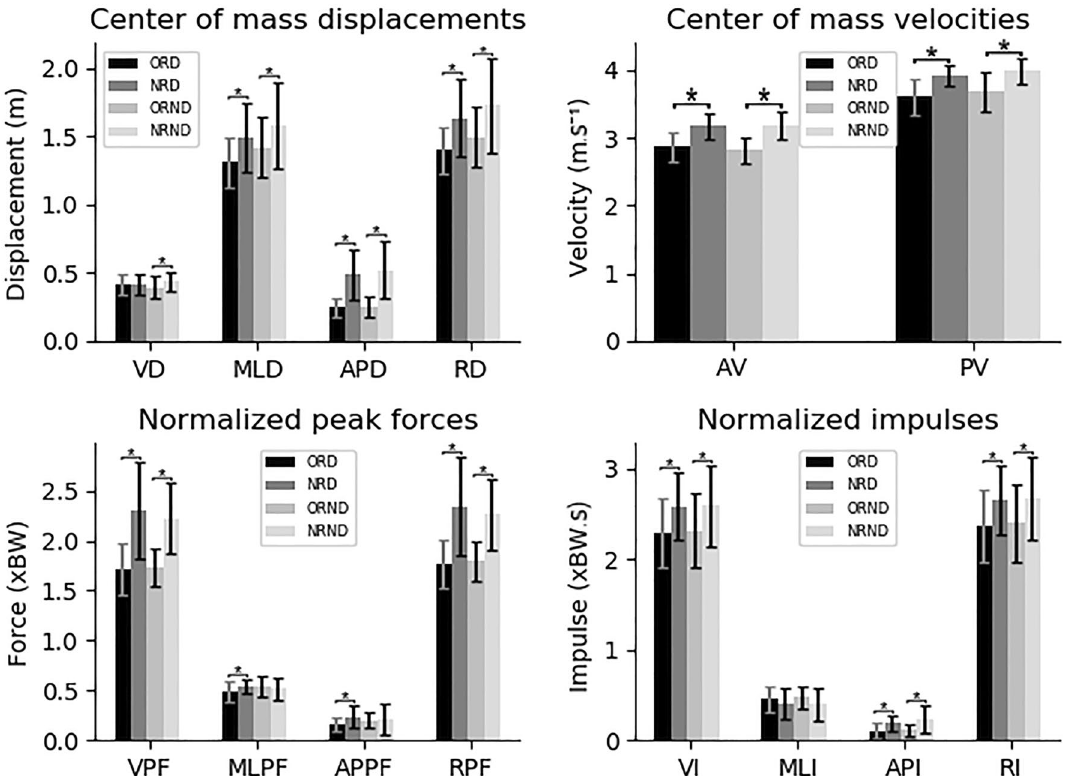
Figure 4. Average and standard deviation of the dive variables with the trials divided according to the rules and lower limbs laterality, comparing the old and new rule in each diving side. *p < 0.05. ORD, trials with the old rule to the side of the dominant lower limb; NRD, trials with the new rule to the side of the dominant lower limb; ORND, trials with the old rule to the side of the non-dominant lower limb; NRND, trials with the new rule to the side of the non-dominant lower limb; VD, vertical displacement; MLD, mediolateral displacement; APD, anteroposterior displacement; RD, resultant displacement; AV, average velocity; PV, peak velocity; VPF, vertical peak force; MLPF, mediolateral peak force; APPF, anteroposterior peak force; RPF, resultant peak force; VI, vertical impulse; MLI, mediolateral impulse; API, anteroposterior impulse; RI, resultant impulse; m, meters; s, seconds; xBW, times body